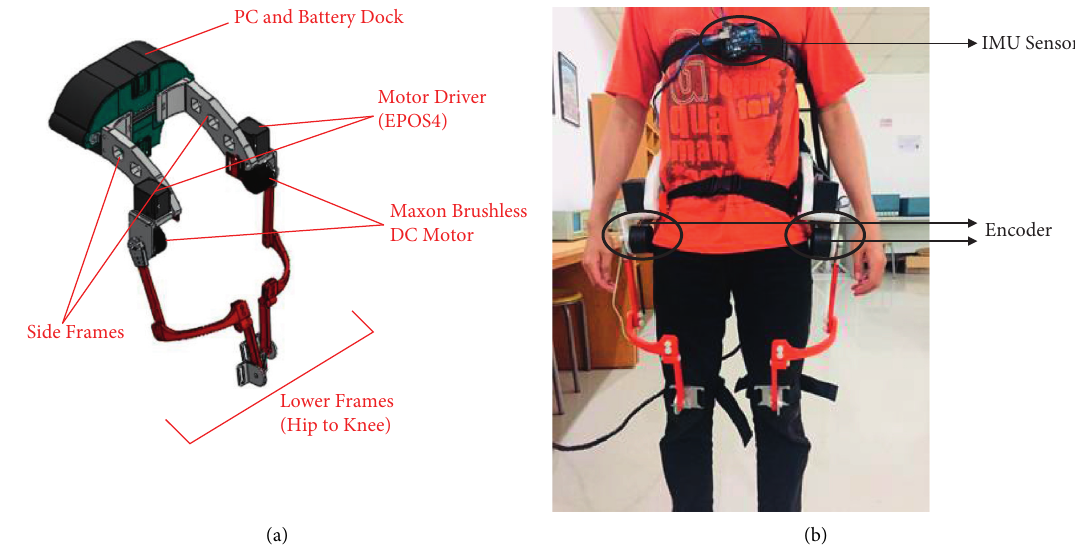
Figure 1: The proposed exoskeleton. (a) Mechanical design. (b) Photograph of the prototype.